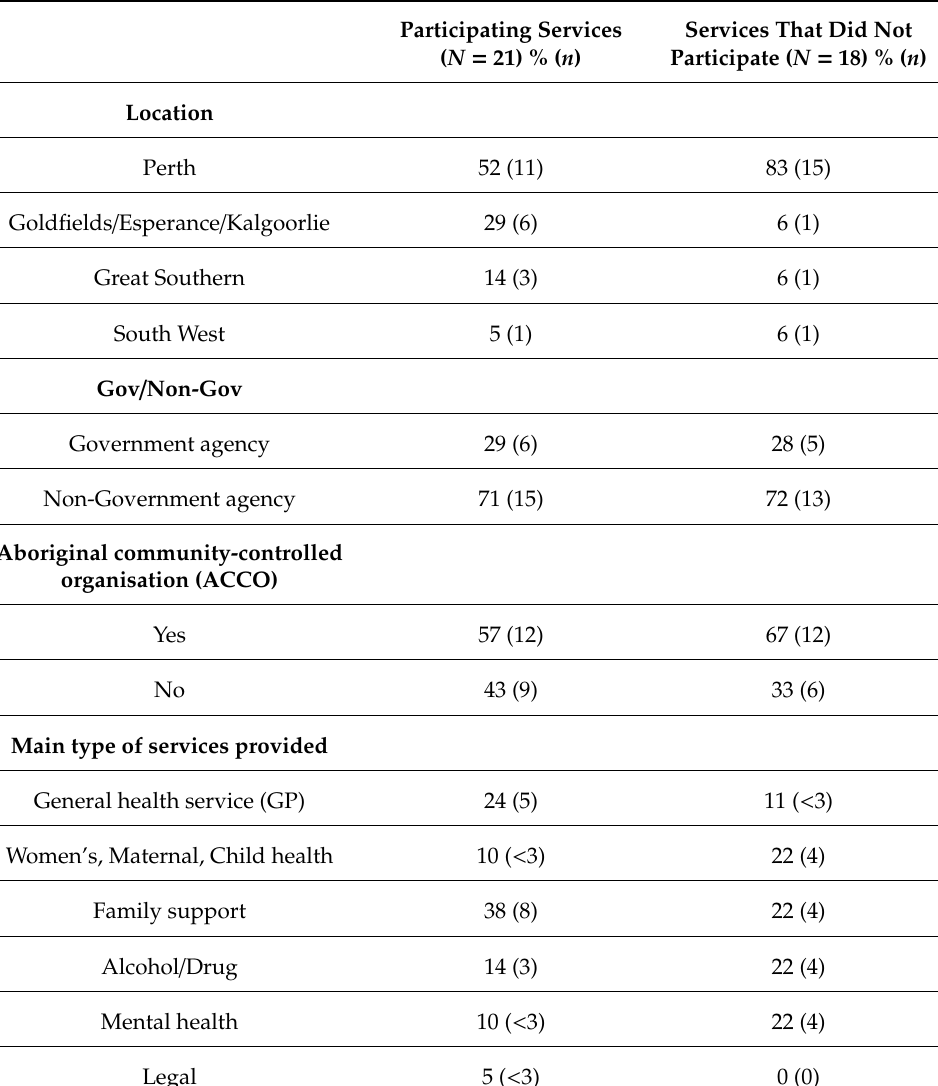
Table 1. Characteristics of responding and non-responding